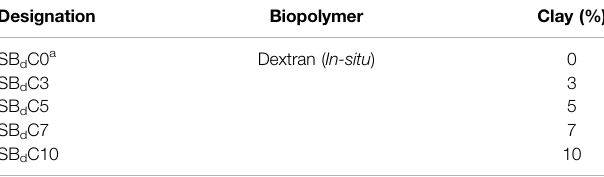
TABLE 4 | Sample designation for Needle penetration